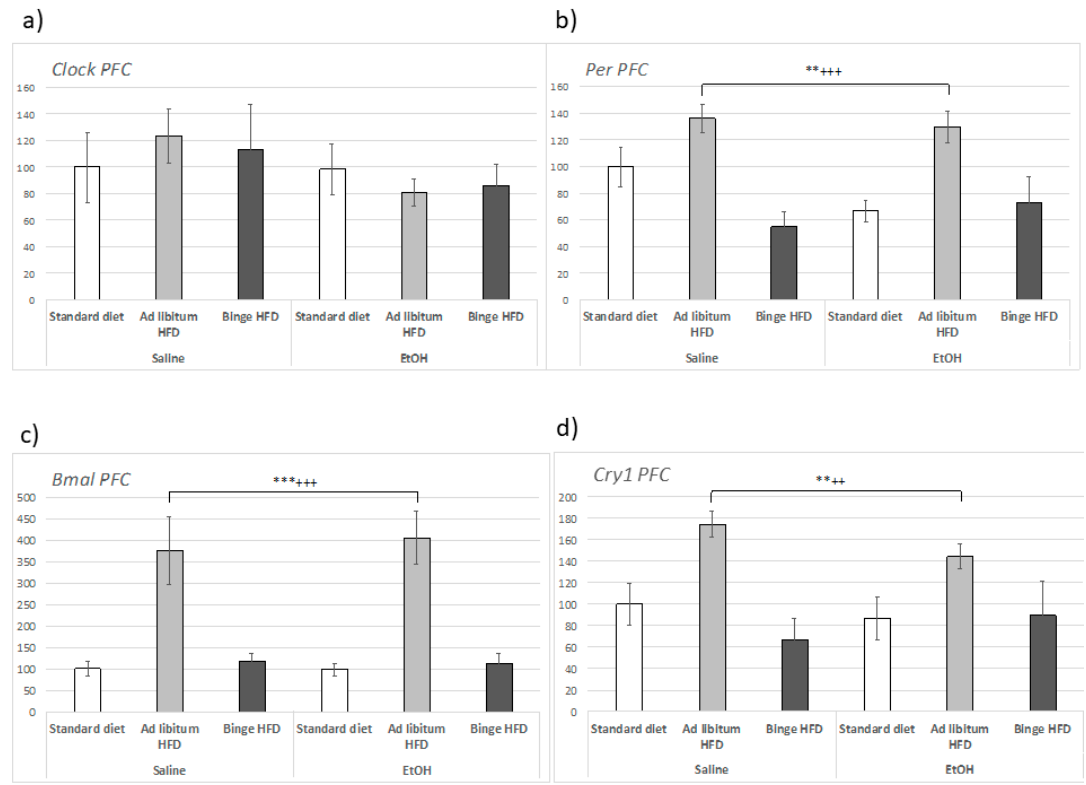
Figure 6. Effect of an ad libitum or binge HFD exposure and EtOH binge on adolescent mice in the circadian gene expression in the prefrontal cortex (PFC). ( a ) Clock ; ( b ) Per2 ; ( c ) Bmal1 ; ( d ) Cry1 . Data are presented as mean (±SEM) *** p < 0.001; ** p < 0.01 with respect to the standard diet; +++ p < 0.001; ++ p < 0.01 with respect to the binge HFD.